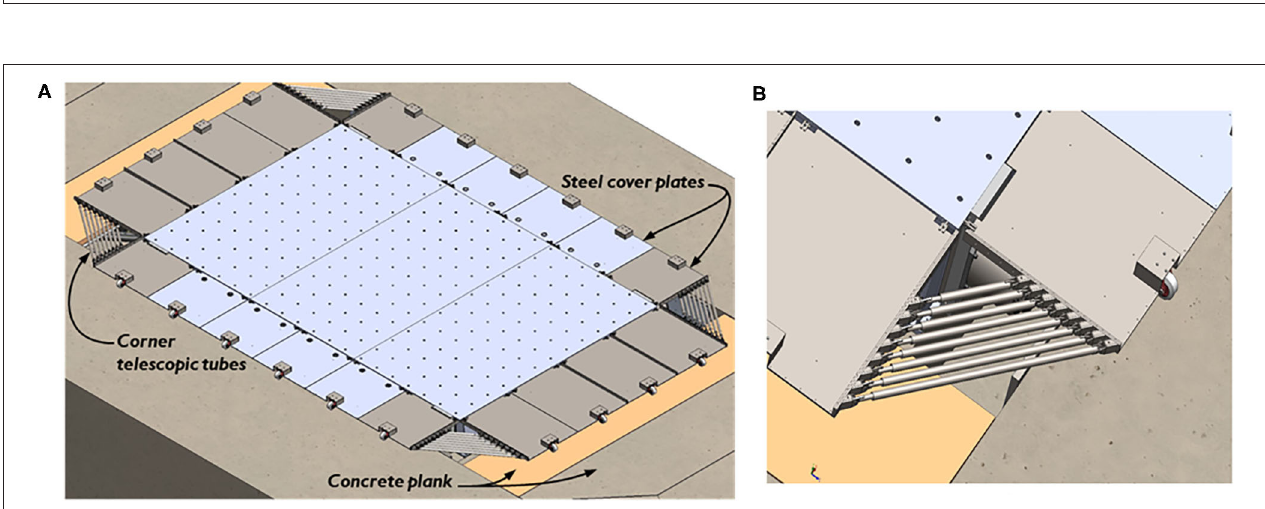
FIGURE 7 | View and rendering of the cover plate system: (A) steel plates locations in the at rest position, and (B) steel plates and telescopic tubes at the corners.